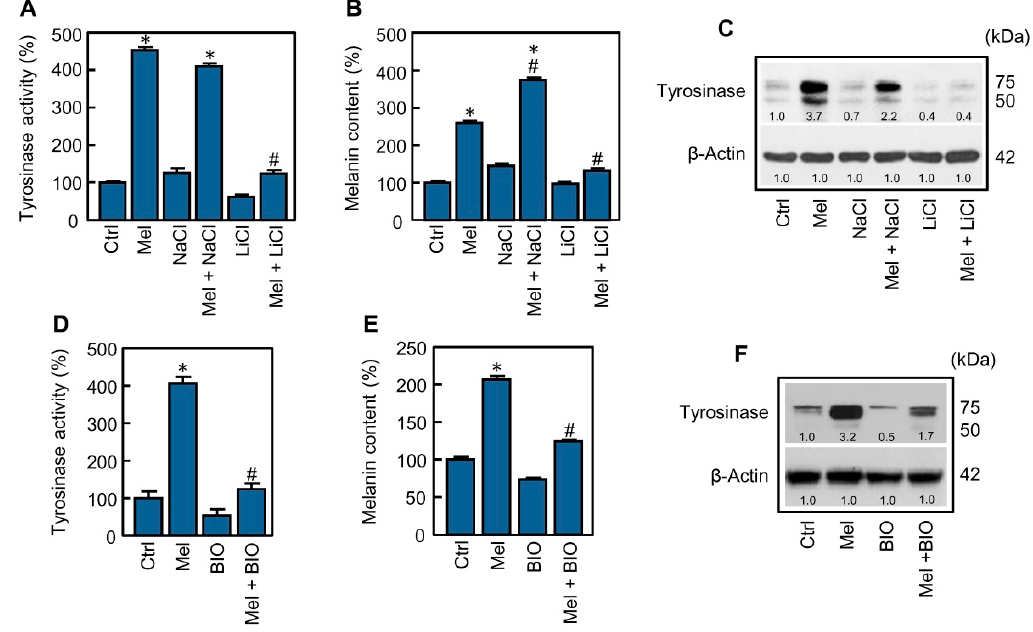
Figure 3. E ff ect of GSK-3 inhibitors on activation of melanogenesis by melatonin. ( A – C ) The cells were pre-incubated with 20 mM LiCl or 20 mM NaCl for 2 h and then treated with 1 mM melatonin (Mel) for 72 h. Tyrosinase activity (A) and melanin content (B) were determined and the values expressed as percentages of control. Tyrosinase levels (C) were analyzed by immunoblotting and β -actin was included as a loading control. ( D – F ) The cells were pre-incubated in absence or presence of 0.5 µ M BIO for 2 h and then treated with or without 1 mM melatonin (Mel) for 72 h. Tyrosinase activity (D) and melanin content (E) were measured and the values expressed as percentages of control. The expression of tyrosinase (F) was determined by immunoblotting from lysates. * p < 0.05 vs. control (Ctrl); # p < 0.05 vs. melatonin treatment alone.